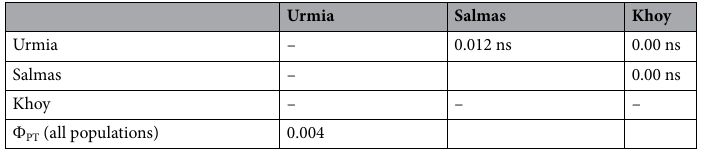
Table 2. Population differentiation (Ф PT , above diagonal) for pairwise comparisons among geographic populations of Sclerotinia sclerotiorum and overall value for all populations. ns, non significant.